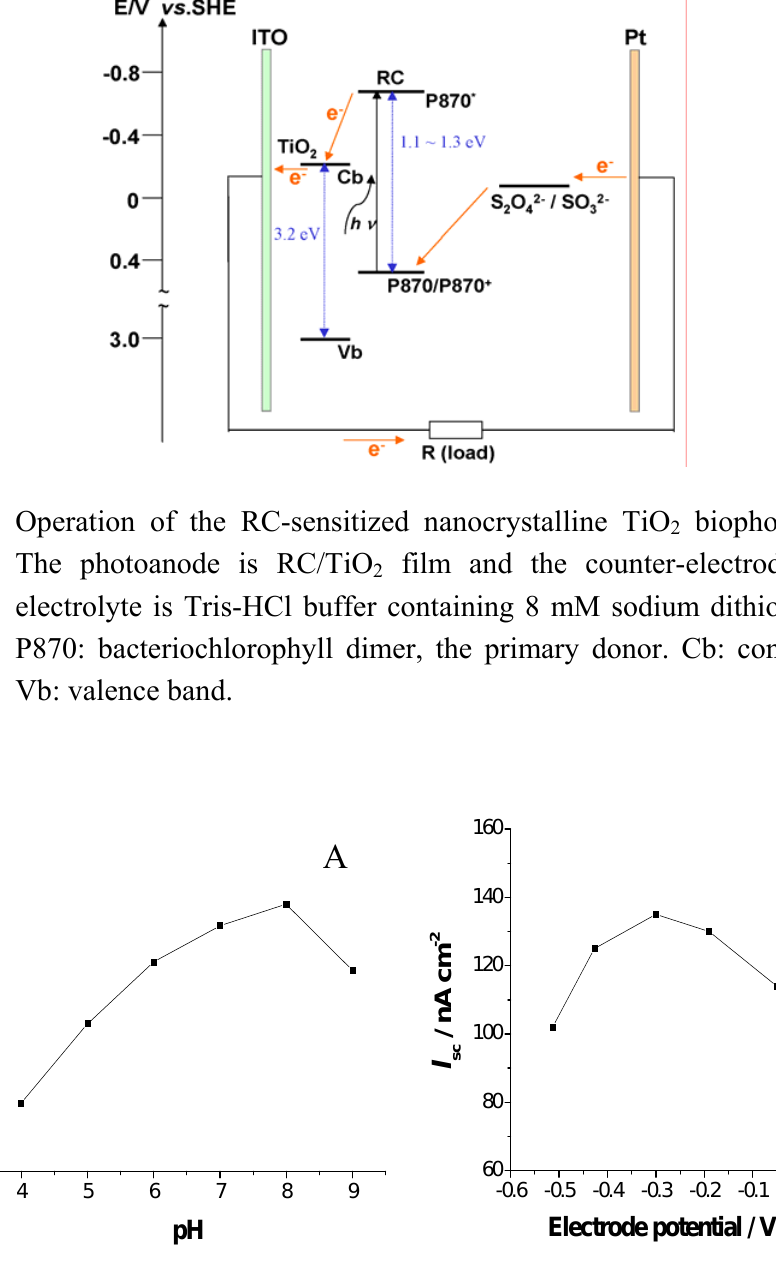
= 0.1 mW cm -2 ). inc of the RC/TiO film with the pH of the electrolyte. sc 2 of the RC/TiO film with the electrode bias sc 2